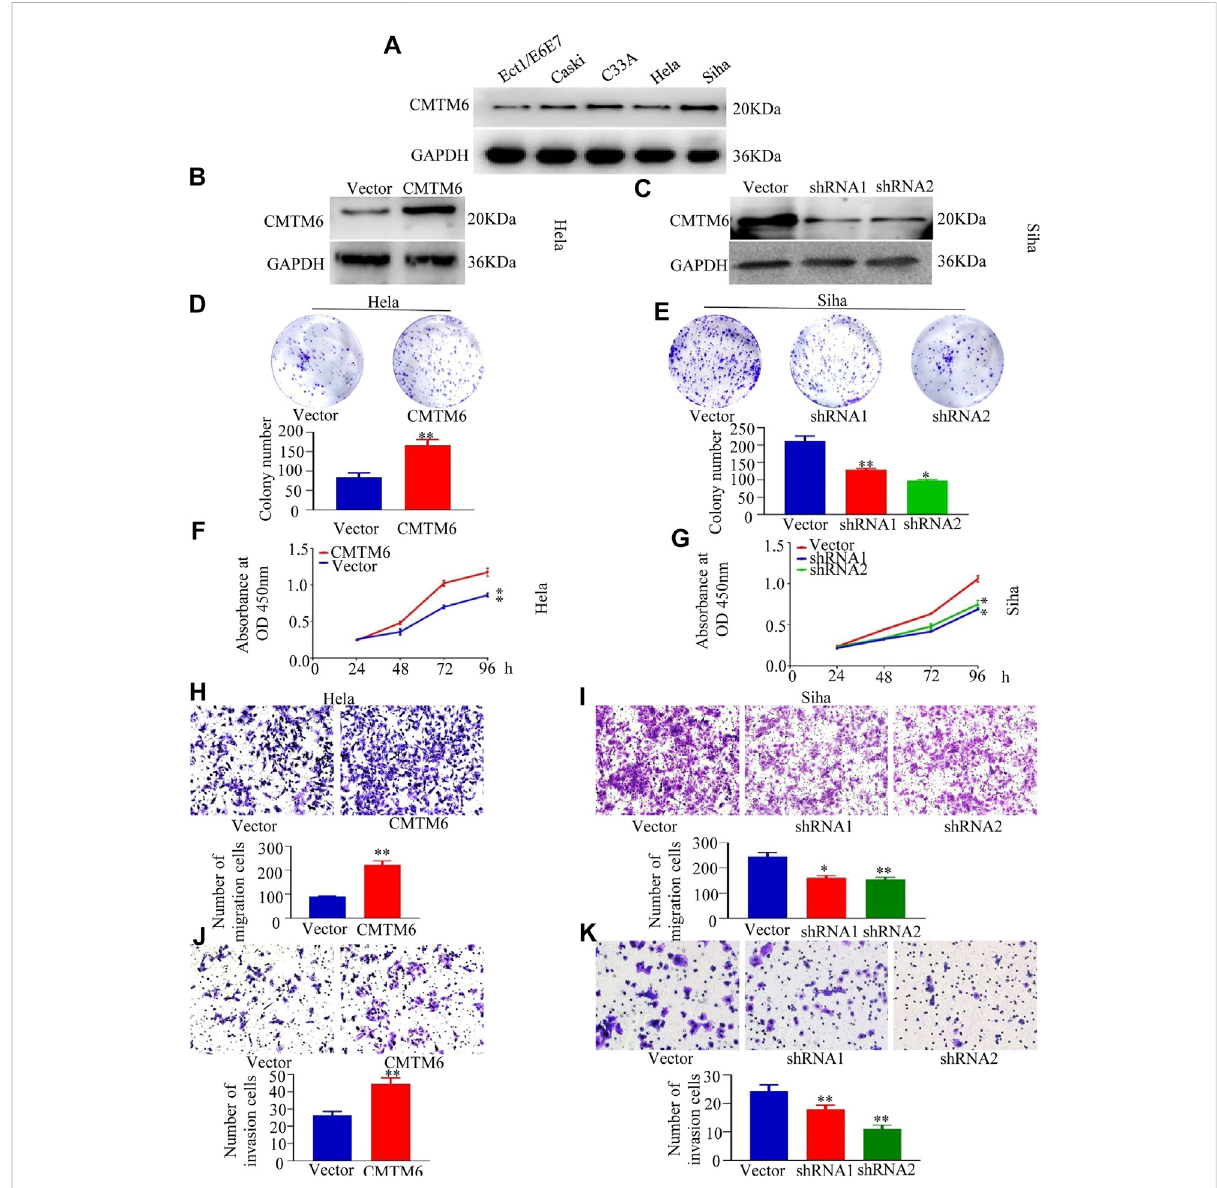
FIGURE 3 CMTM6promotescervicalcancerproliferationandmetastasis invitro (A) WesternblottinganalysisofCMTM6levelsinCCcelllines. (B) Western blotting analysis of CMTM6 protein expression in SiHa cell transduced with lentivirus expressing CMTM6 or with the empty vector. (C) Hela cell was transduced with a lentivirus encoding a CMTM6 shRNA or scrambled shRNA. (D,E) Colony-forming ef fi ciency of HCC cells. (F,G) Results of CCK-8 assay. (H – K) CellmigrationwasevaluatedusingTranswellassayinCCcellswithoverexpressionandknockdownofCMTM6. (C – D) Cellinvasion was assessed using Transwell assay. The experiments were repeated at least three times. * p < 0.05; ** p <